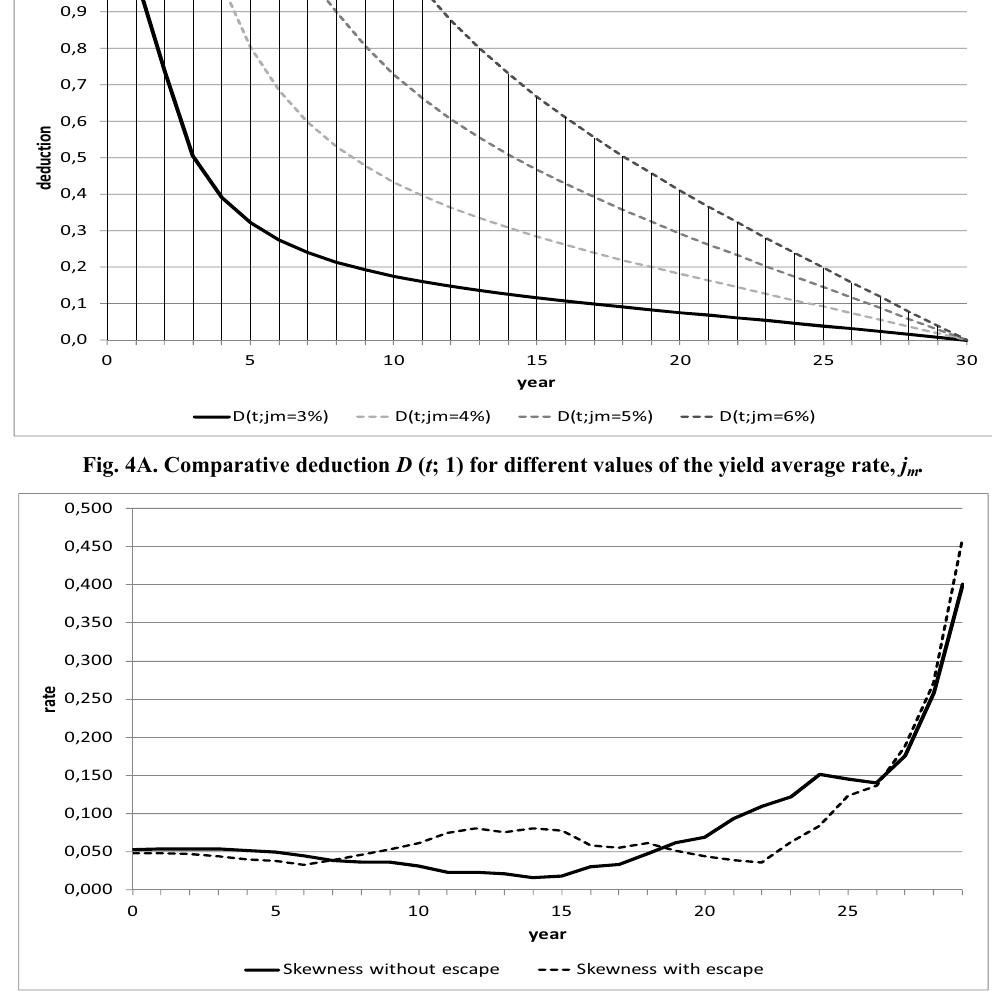
(cid:5) U evaluated in presence and in absence of contract t